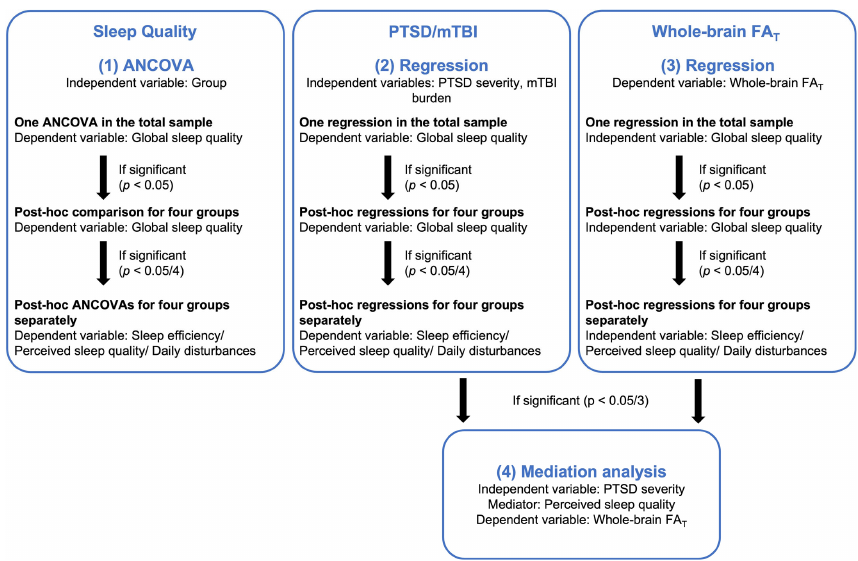
Figure 1. Hierarchical statistical approach. Note. PTSD, post-traumatic stress disorder; mTBI, mild traumatic brain injury; PSQI, Pittsburgh Sleep Quality Index; FA T , fractional anisotropy tissue. This figure illustrates the hierarchical statistical